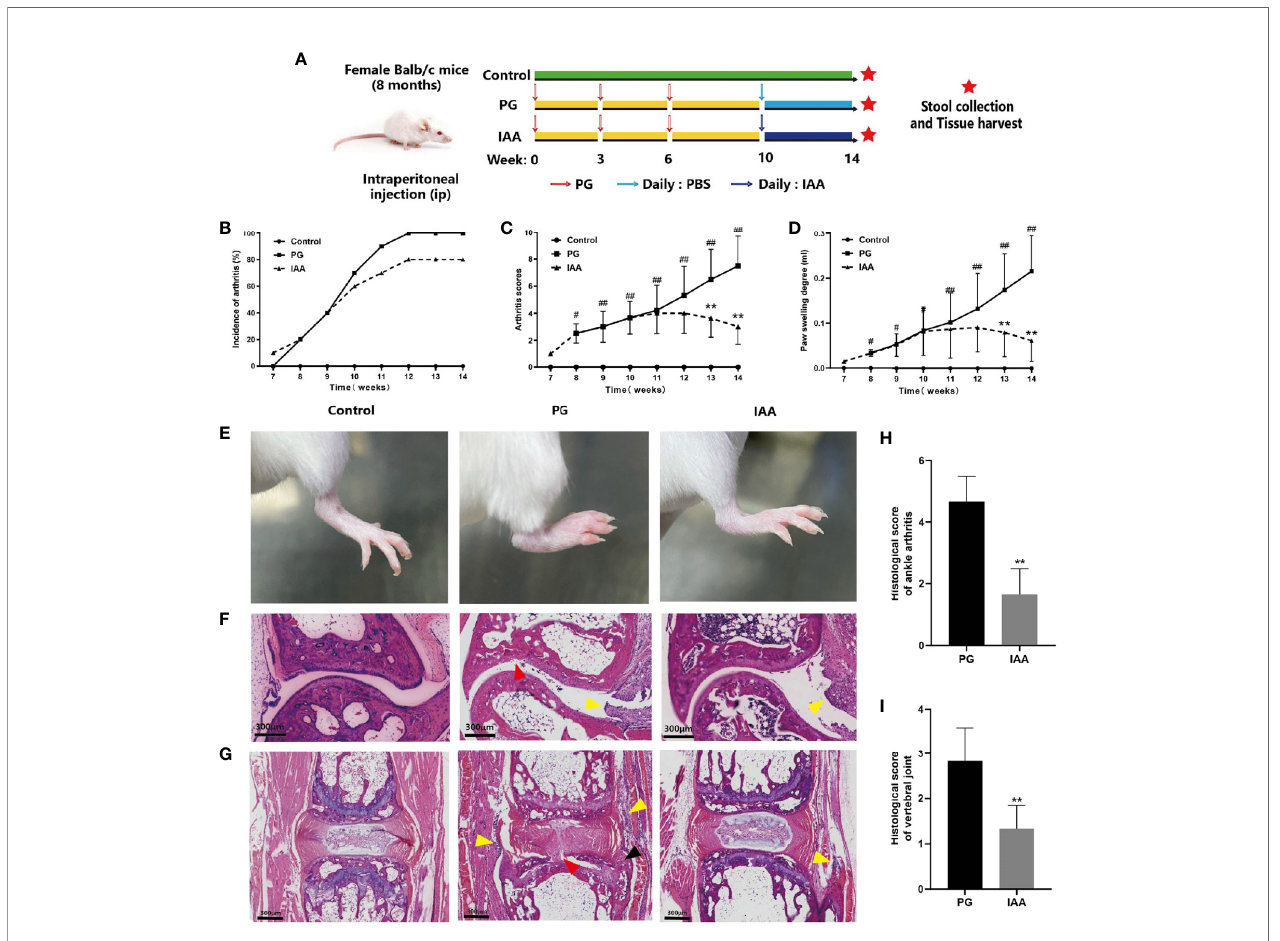
FIGURE 1 | IAA attenuates disease progression and severity in PG-induced AS mice. (A) Schematic diagram for study design. Incidence of arthritis (B) , arthritis index score (C) , and degree of hind feet swelling (D) in three groups of mice (n = 10). (E) Representative pictures of the hind feet in three groups of mice at the end of week 14. (F) Representative pictures of ankle joint sections in three groups of mice (HE staining, scale bar = 300 µm). PG group was characterized by in fl ammatory cell in fi ltration in the synovium of the joint capsule (yellow arrow), cartilage degeneration, and bone erosion on the articular surface (red arrow). (G) Representative pictures of vertebral joint sections in three groups of mice (HE staining, scale bar = 300 µm). PG group was characterized by in fl ammatory cell in fi ltration in the ligaments around the intervertebral disc (yellow arrow), partial destruction of intervertebral disc structure (red arrow), and new chondrocytes (black arrow). (H) Histologic scores for ankle joint sections in the PG and IAA groups (n = 6). (I) Histologic scores of vertebral joint sections in the PG and IAA groups (n = 6). Data are expressed as the mean ± standard deviation (SD); # p < 0.05, ## p < 0.01 vs. control; ** p < 0.01 vs. PG alone. IAA, indole-3 acetic acid; PG, proteoglycan; AS, ankylosing spondylitis; HE, hematoxylin and